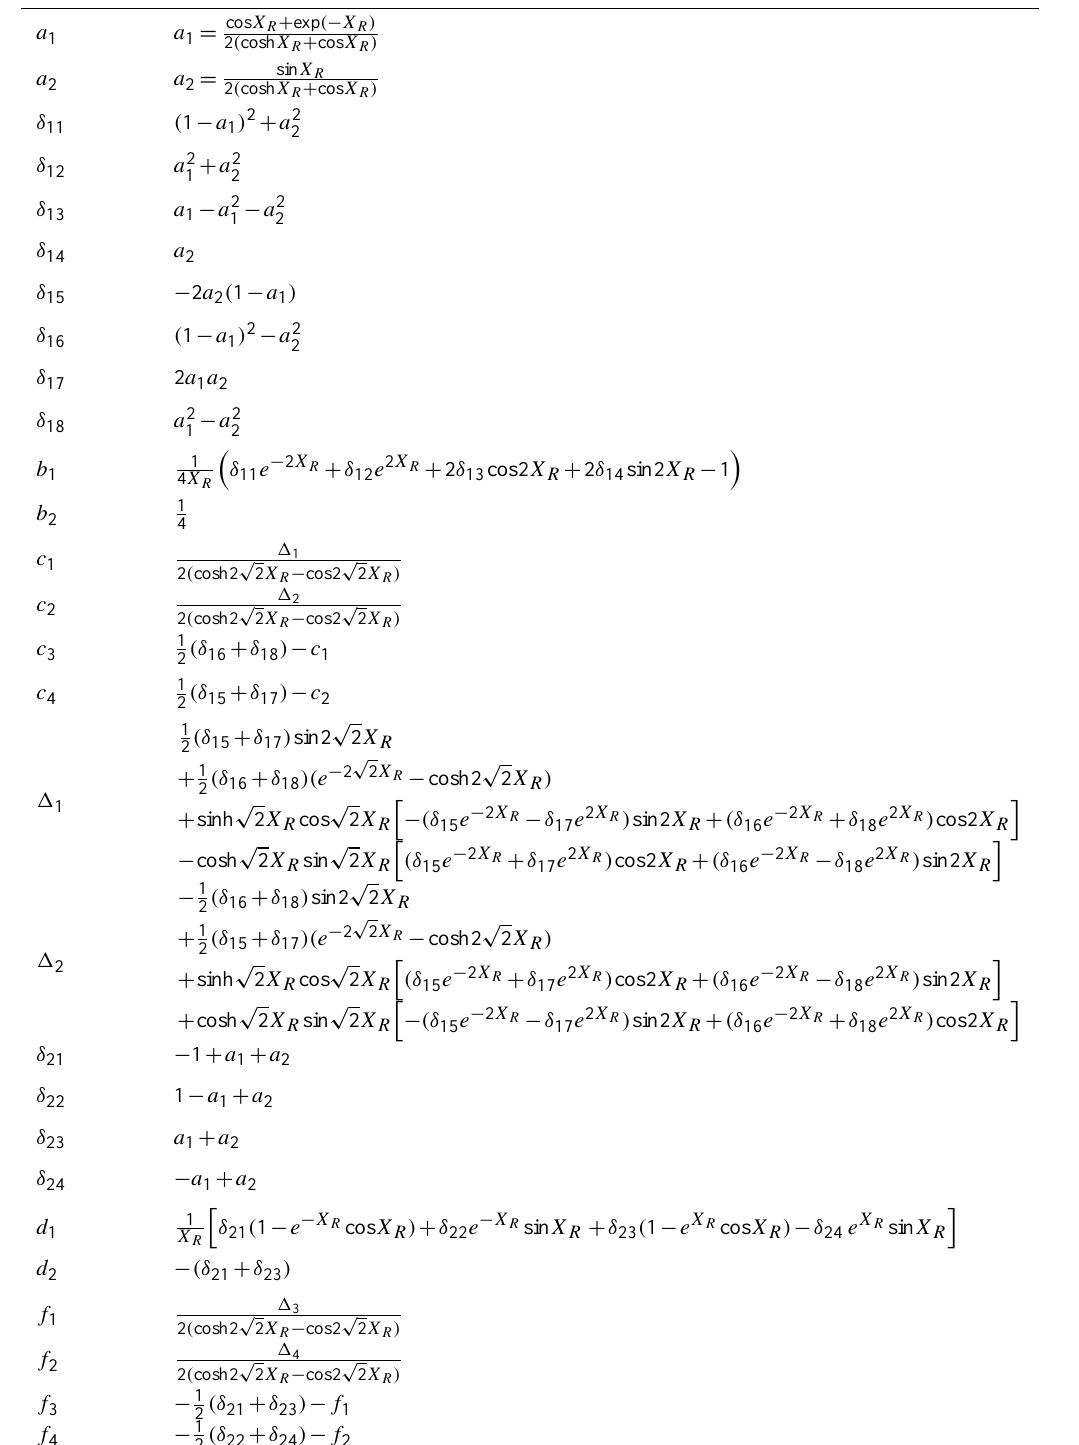
Table 1. Definition of